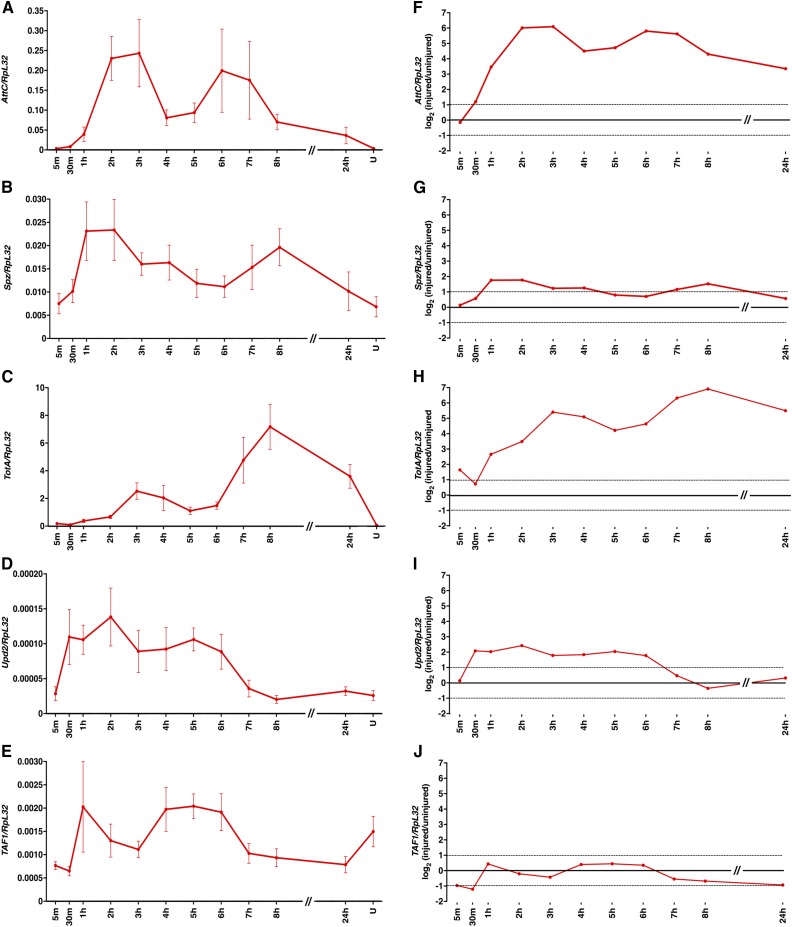
Innate immune response genes had different expression profiles over the 24 hr period following primary injuries in younger w1118 flies fed food. (A–E) Expression of the indicated genes relative to RpL32 at the indicated time points following the standard injury protocol. Note that y-axis scales differ among graphs and that the x-axis is not to scale between 8 and 24 hr. U indicates uninjured flies at the 24 hr time point. Each data point is the average and SEM of at least three biological replicates. These data are shown in comparison to other conditions in Figure 6, Figure 7, Figure 8, Figure 9, and Figure 10. Note that the y-axis scales are different in Figure 6, Figure 7, Figure 8, Figure 9, and Figure 10. (F–J) Log2 expression difference in injured relative to uninjured flies of the indicated genes normalized to RpL32. Dotted lines indicate a twofold change in expression. Note that the x-axis is not to scale between 8 and 24 hr.